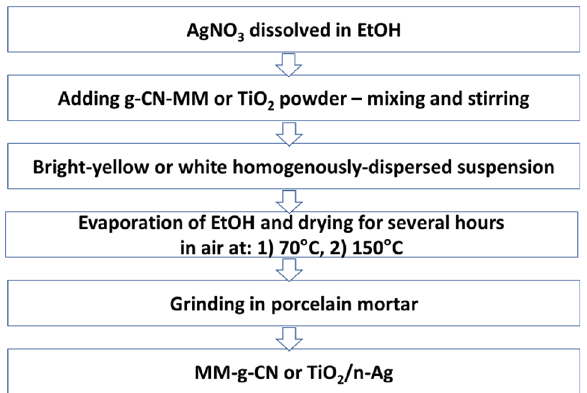
Figure 1. The flowchart of the synthesis of TiO 2 -A-n% Ag and of MM-g-CN-n% Ag